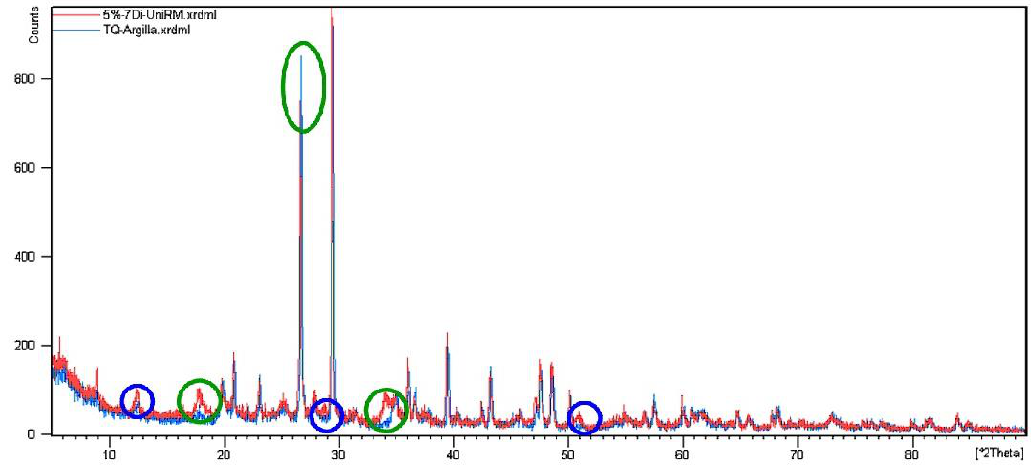
ff ractogram (red) and TQ0 di ff ractogram Figure 8. Overlay of 7 d TQ5 diffractogram (red) and TQ0 diffractogram (blue). Figure 8. Overlay of 7 d TQ5 di Figure 8. Overlay of 7 d TQ5 diffractogram (red) and TQ0 diffractogram (blue).